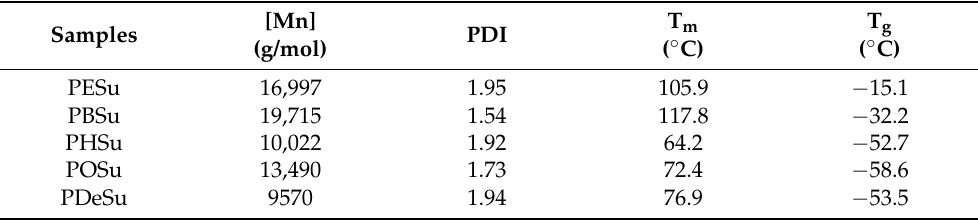
Table 2. Molecular weights and thermal properties of synthesized poly(alkylene succinate)s.